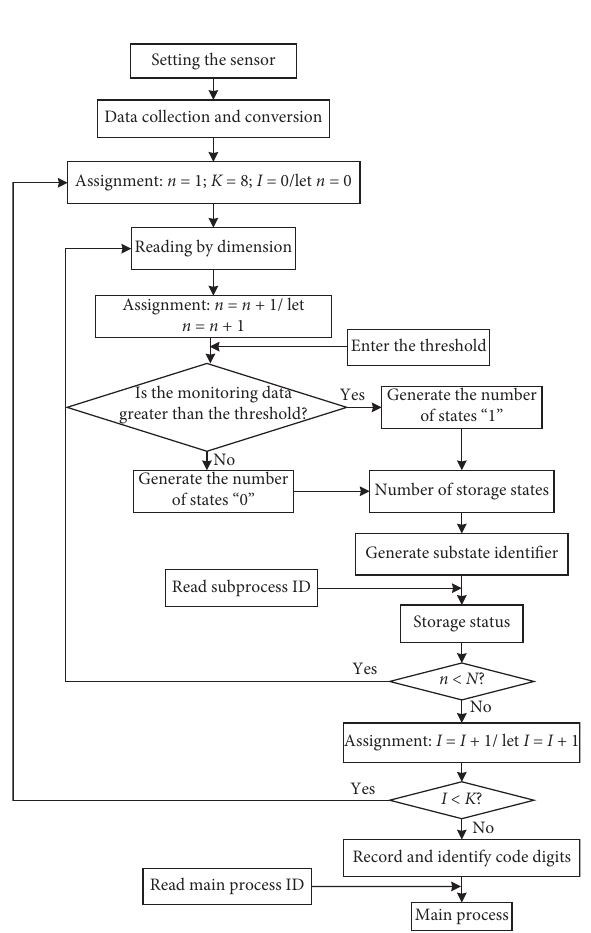
Figure 2: Logic flowchart of procedure identification for